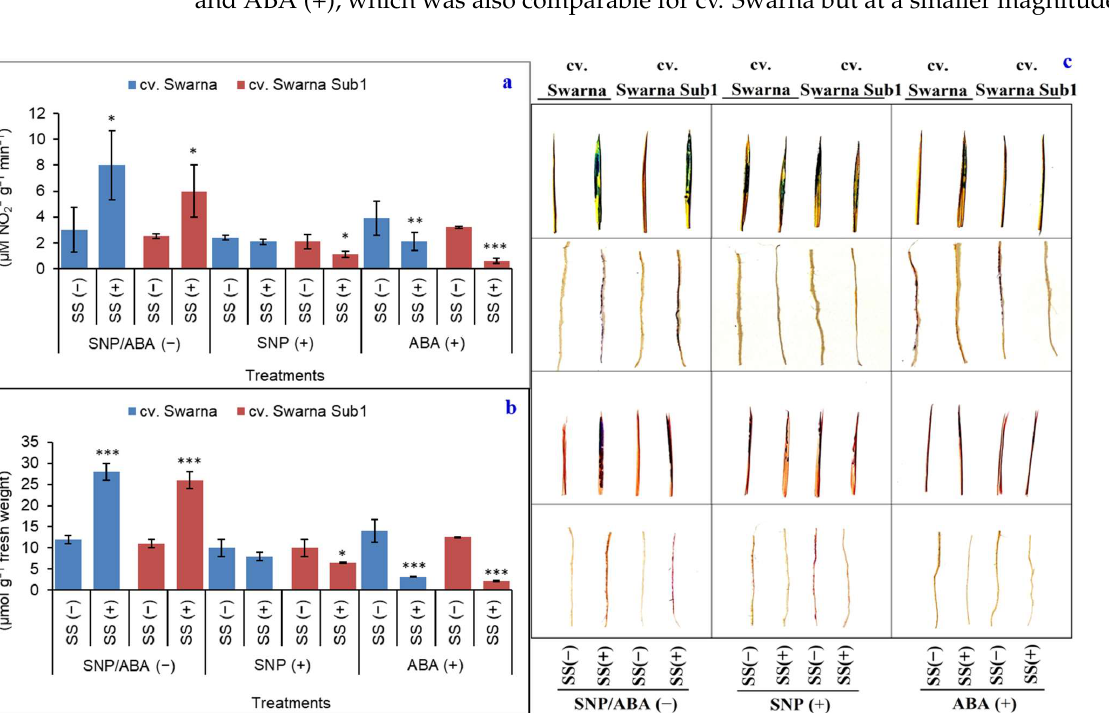
Figure 8. Changes in superoxide generation ( a ), hydrogen peroxide accumulation ( b ) and their histochemical detection in leaves and roots ( c ) of two rice genotypes (cv. Swarna and Swarna Sub1) under salinity stress [SS (+)] and non-salinity stress [SS (−)] for 72 h with [SNP (+) or ABA (+)] or without [SNP/ABA (−)] priming for 24 h. Data are presented in bars with mean ± SE ( n = 3) from independent experimental sets and the significant values are represented as * ( p ≤ 0.05), ** ( p ≤ 0.01) and *** ( p ≤ 0.001) by student’s t -test to denote the significant difference between SS (−) and SS (+) of SNP/ABA (−) as well as SNP (+) and ABA (+) of each rice genotype.